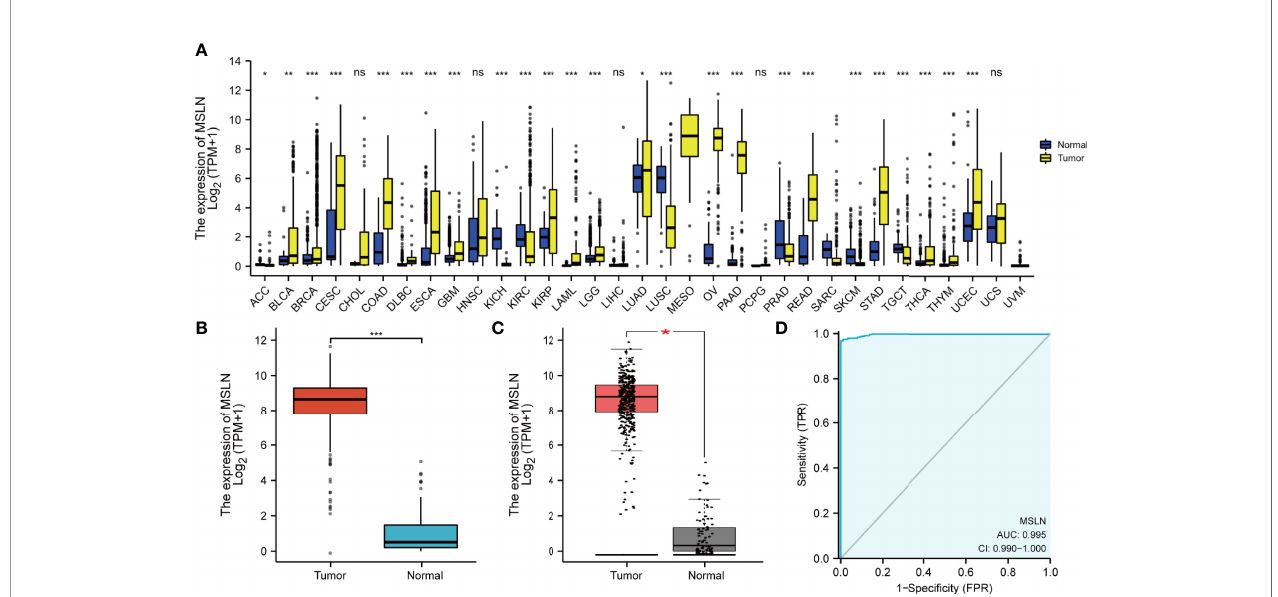
FIGURE 1 | Expression of MSLN in pan-cancer. (A) MSLN expression in tumor and normal tissues in TCGA and GTEx pan-cancer data. (B) MSLN expression in OV in TCGA and GTEx pan-cancer data. (C) MSLN expression in OV in GEPIA2 database. (D) Receiver operating characteristic (ROC) curve for MSLN expression in OV. ns, p ≥ 0.05; *, p < 0.05; **, p <0.01; ***, p <0.001, ns, no signi fi